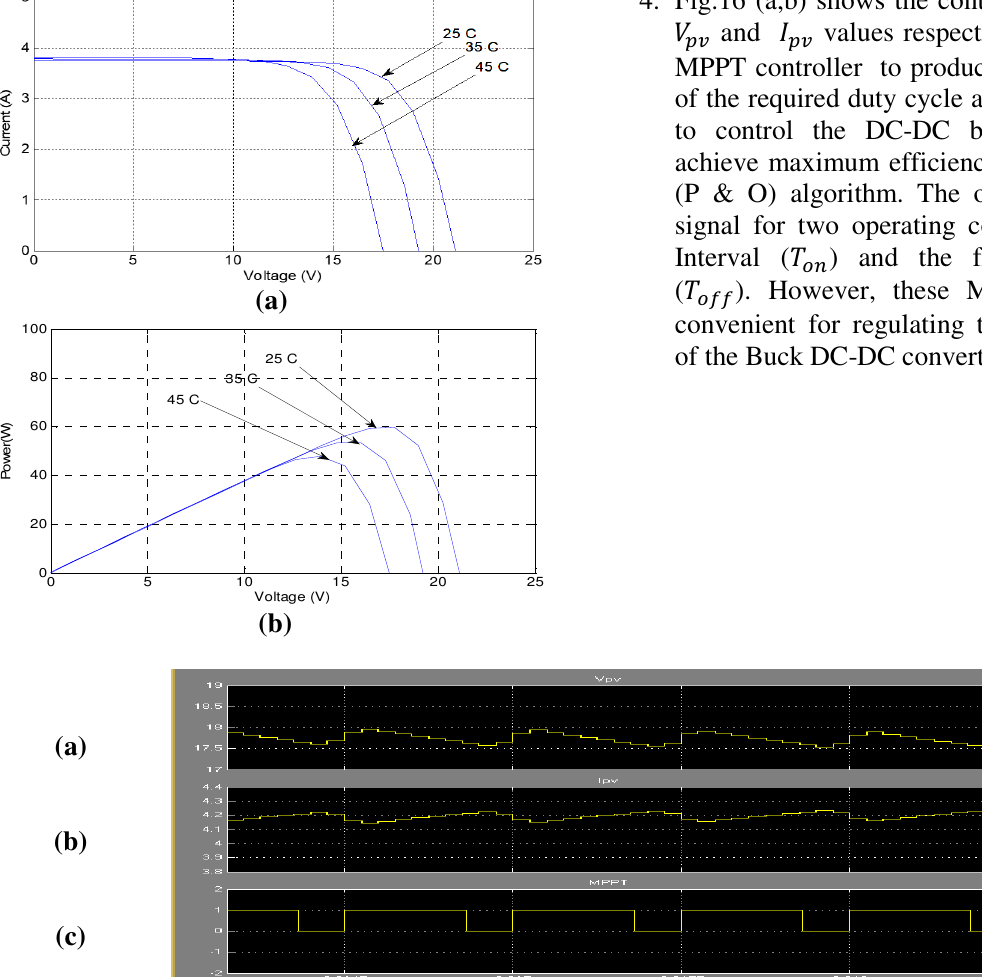
, and MPPT switching Fig.16. ‰ Š‹ Œ Š‹